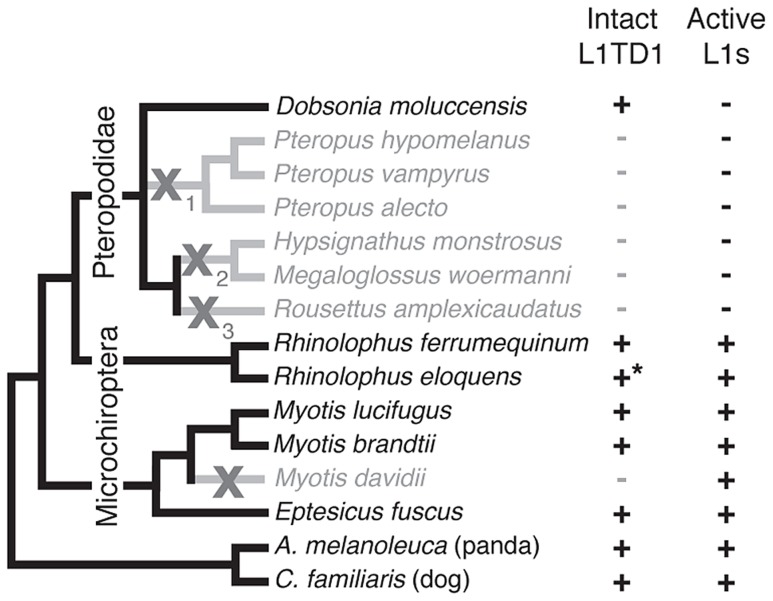
Loss of L1TD1 in megabats appears to follow the loss of L1 activity.We obtained L1TD1 sequences from thirteen bat species (Materials and Methods). We show a species tree partly based upon a published megabat phylogeny [82], inferring placement of additional taxa using species from the same genus. In addition, we used our L1TD1 sequences to resolve relationships in the Pteropus and Myotis/Eptesicus clades. Species in which L1TD1 appears intact are shown in black, and those in which L1TD1 harbors inactivating mutations (stop codons, frameshifting insertions/deletions) are shown in gray. Some species share the same inactivating mutation(s) represented by the subscripts of the gray X symbols, suggesting L1TD1 was lost three independent times in the megabats. For one species, R. eloquens (starred), we were only able to obtain part of coding exon 1 of L1TD1, but this region is intact. Presence or absence of active L1s is based upon previous data [44] and analysis of the M. davidii genome assembly (Yang and Wichman, unpublished data).